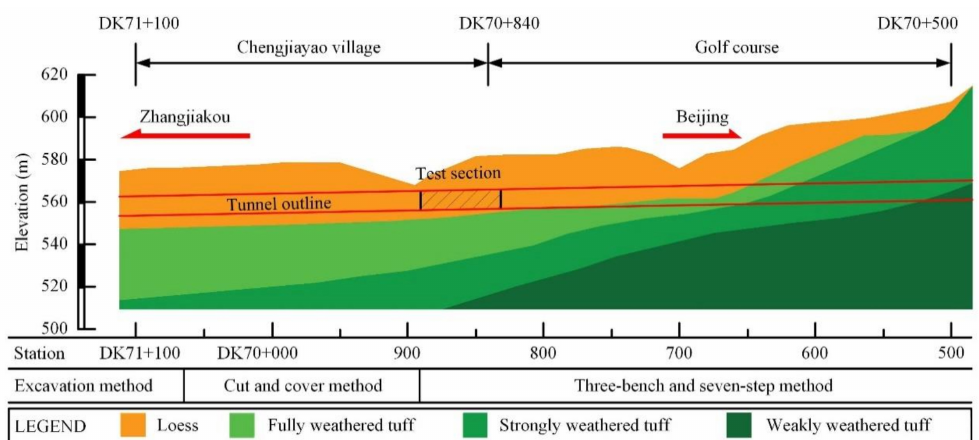
Figure 2. Aerial photo of the project area.